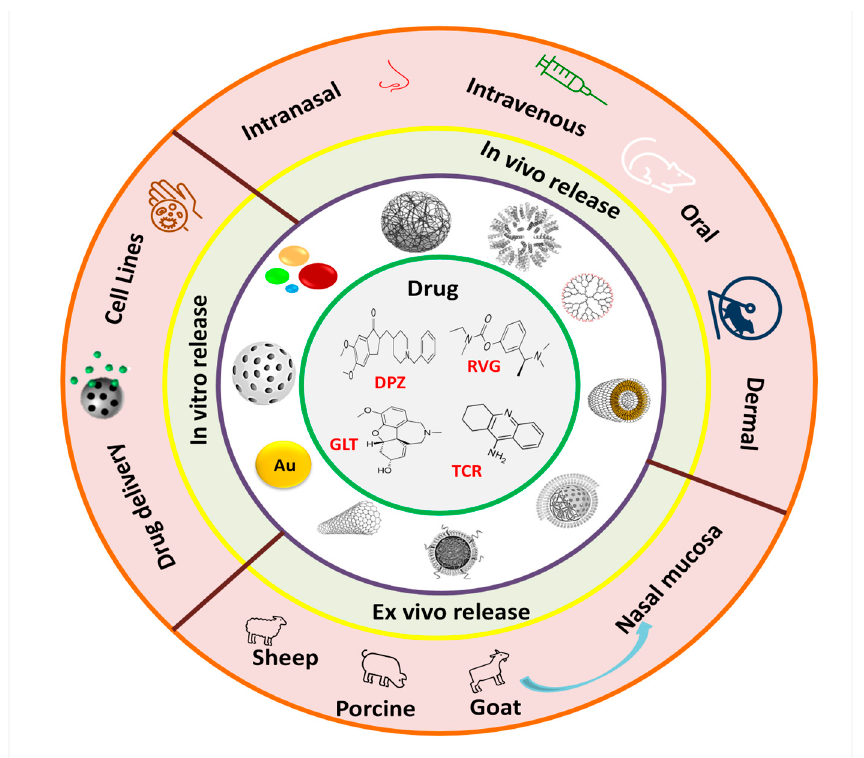
Figure 7. Chemical structures of the main anticholinergic drug were stabilized on the different nanomaterials for subsequent in vitro, ex vivo, and in vivo release using sheep, porcine, and goat nasal mucosa. While rats of several strains and mice were used as animal models administered by nasal, oral, transdermal, and subcutaneous methods via the drug-nanoparticles formulations. Abbreviations: DPZ (Donepezil), RVG (Rivastigmine), GLT (Galantamine), TCR (Tacrine).